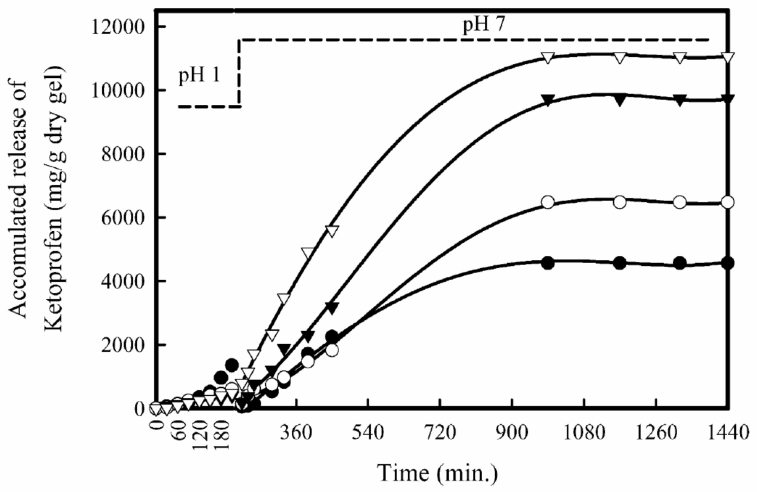
Figure 11. Release profile of ketoprofen from (acrylic acid/DMAEMA) copolymers of different acrylic acid contents in buffer solution of pH 1 for 3.5 h followed by buffer solutions of pH 7 up to 24 h: ( • ) 75%, ( ◦ ) 80%, ( (cid:72) ) 90% and ( ∇ ) 100% acrylic acid content (used with copyright permission)